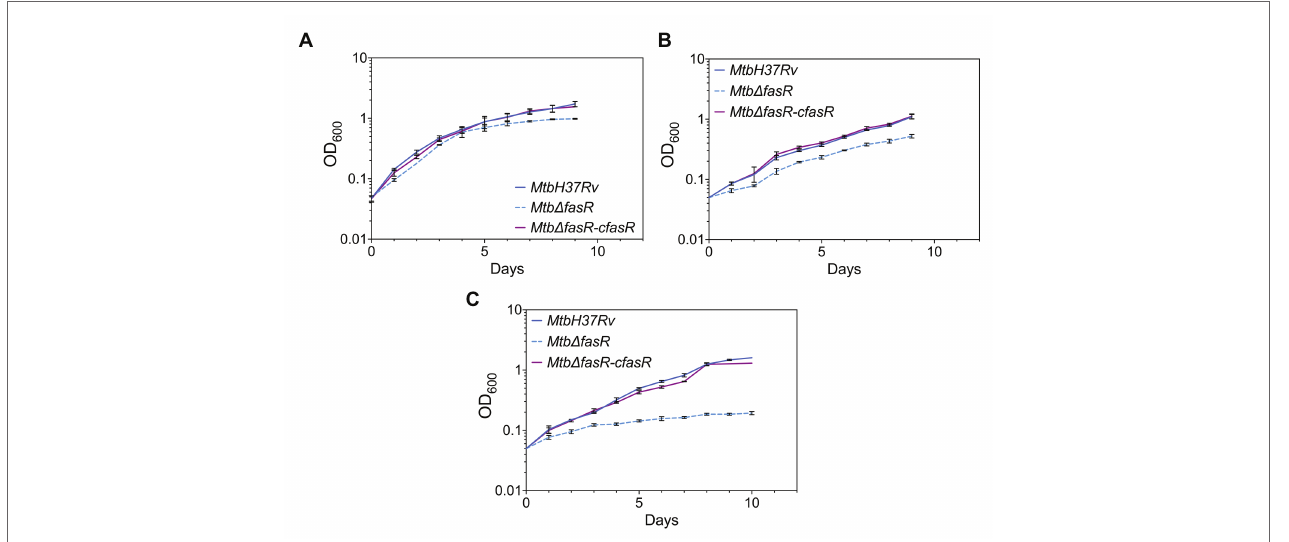
FIGURE 2 | Growth of Mycobacterium tuberculosis strains. Growth curves of M. tuberculosis wild-type strain ( Mtb H37Rv), fasR conditional knockdown strain ( Mtb Δ fasR -c fasR ) grown without ATc (complemented strain) and fasR KO strain ( Mtb ∆ fasR ) were obtained in 7H9 complete medium (A) , 7H9 without OADC medium (B) , and Sauton medium (C) . Growth was followed by measuring OD 600 nm . Curves correspond to mean ± standard deviation of three independent